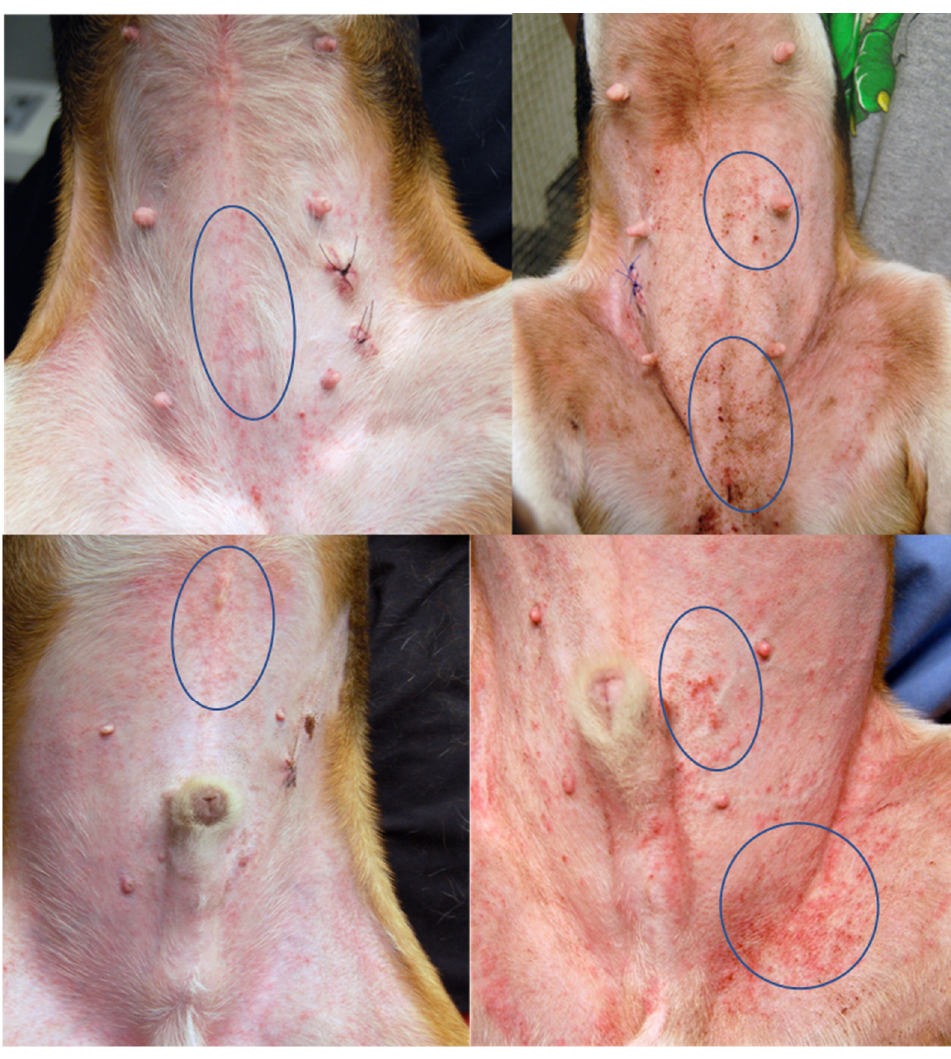
Figure 4. Close up of images of lesions of atopic dermatitis ( left ) and atopic dermatitis with superimposed staph infection ( right ). Clinically speaking, the papules that develop after HDM exposure in this model are small and of fairly even size. When a staphylococcal infection develops, the papular eruption becomes larger, and exudative lesions develop, which are then covered with crusts. The circles are areas of example of the differences. Biopsies were taken for reasons not related to this study.